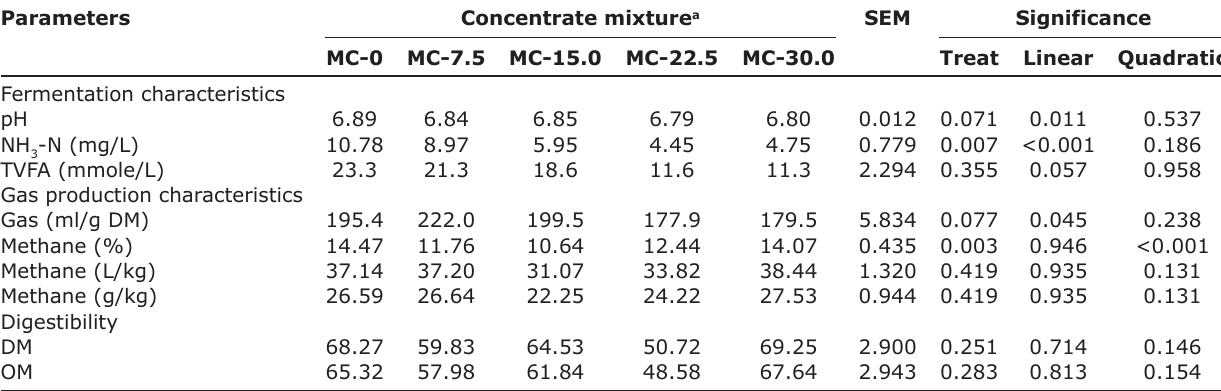
Table-2: In-vitro fermentation gas and fermentation characteristics of the concentrate mixtures having graded levels of mustard cake (means of three observations).